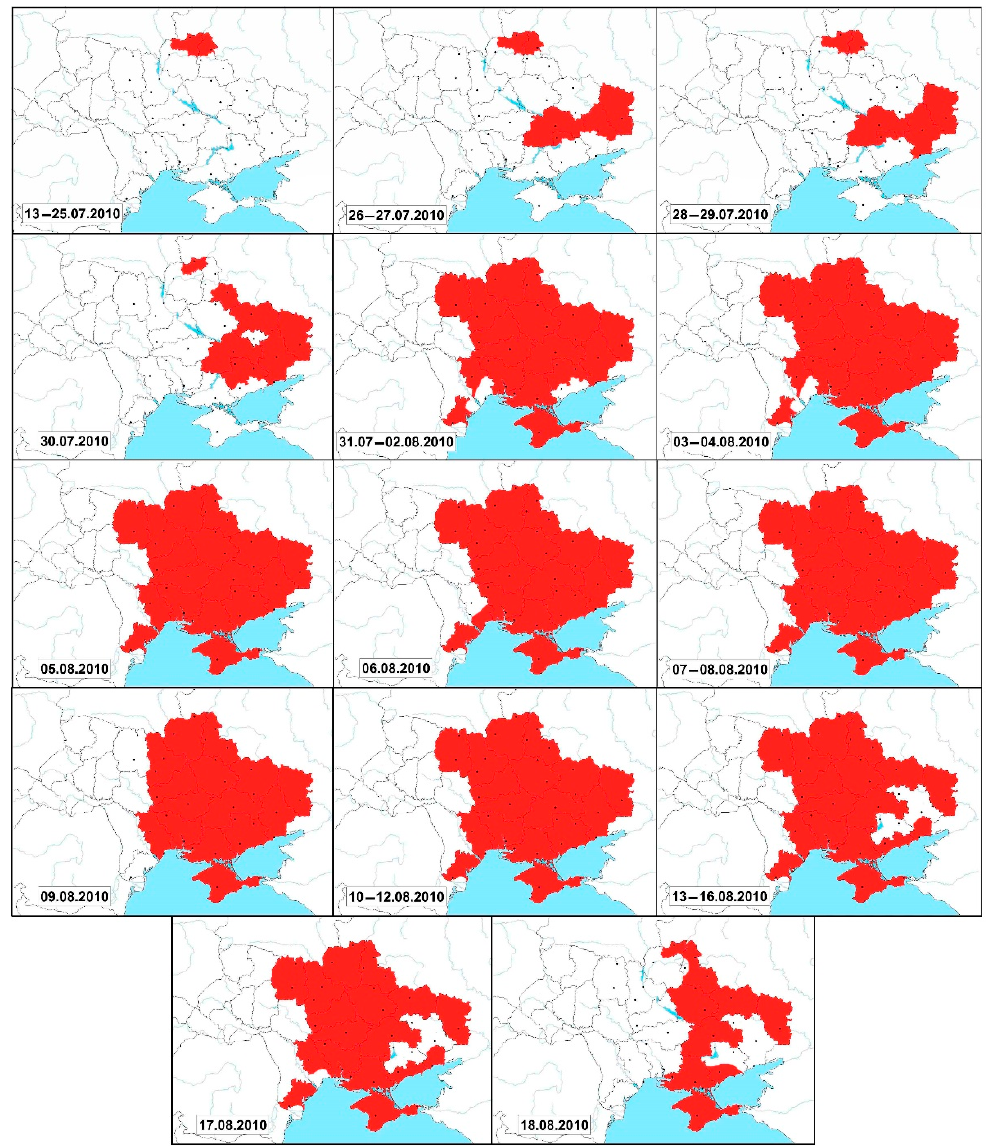
Figure 3. Date of occurrence of the mega-HW in 2010 and the territory where it was observed. During the period from 31 July to 12 August 2010 the mega-heat wave was observed at the vast majority of stations in the Northern, Central, Eastern and Southern regions. It was characterized by very high air temperatures: 42.1 ◦ C in Luhansk (12 August); 39.8 ◦ C in Kharkiv (8 and 10 August); 39.6 ◦ C in Hadiach (2 August); 39.4 ◦ C in Kropyvnytskyi and Poltava (8 August); 39.1 ◦ C in Lozova (8 August); 37.2 ◦ C in Mariupol (9 August); 37.0 ◦ C in Uman (7 August) (Table 3). The mega-heat wave caused significant rising of August 2010 mean air temperature. The difference between mean air temperature of August 2010